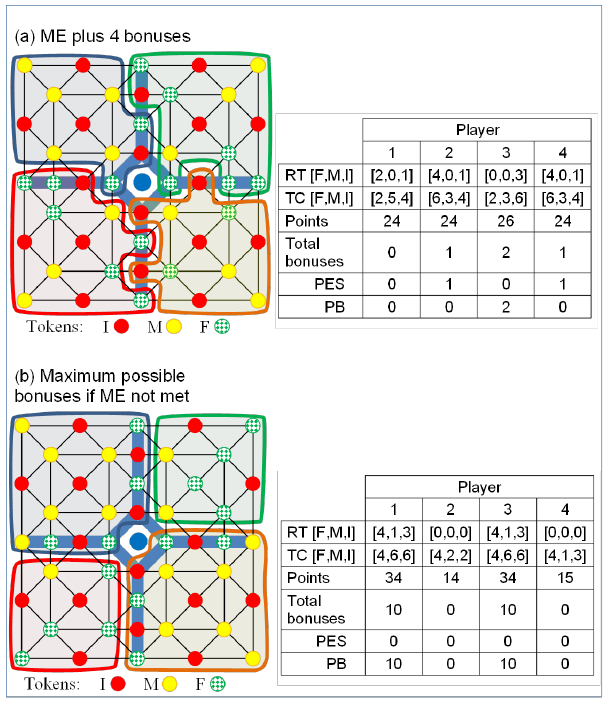
Fig. 2 . Schematic diagrams of the Sierra Springs game board showing results that give the maximum possible number of bonuses for the group of four players in S2, under two different conditions: (a) players stick to the moral economy goal, and (b) players abandon it. Colored lines drawn around each quadrant enclose the tokens placed by each player. In (b), players 1 and 3 have been ceded control of all the riparian sites that are available to them. RT = the set of tokens that the player has placed on riparian sites (format is number of F tokens, number of Ms, number of Is). CT = the complete set of tokens that the player has used (format is the same as for RT). Total bonuses = sum of PES and PB. PES = environmental (hydrological) service bonus and PB = provision bonus, equal to the number of points earned in excess of the 24 needed for